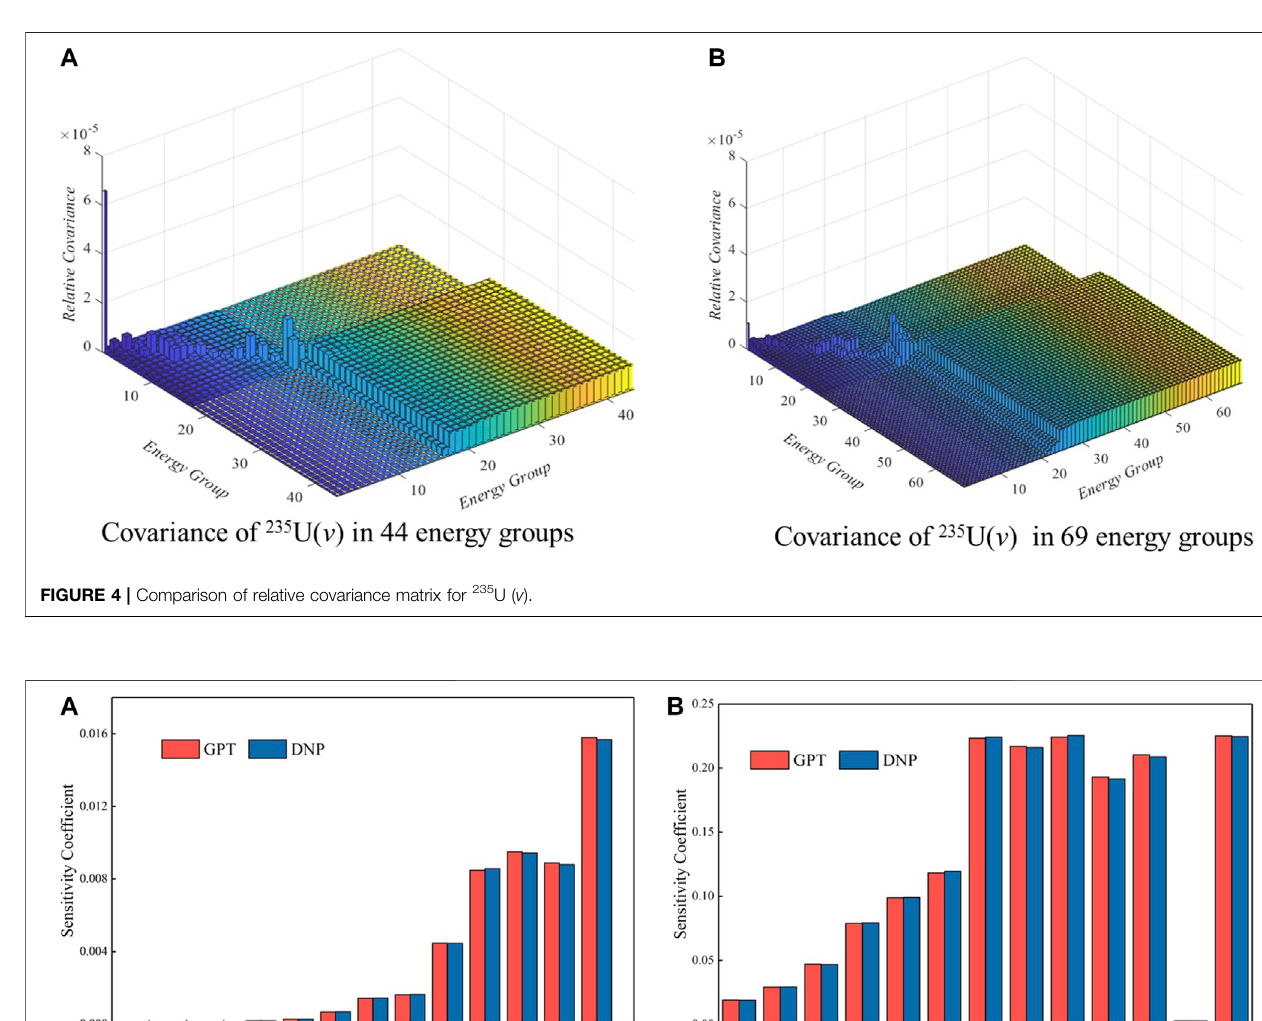
Frontiers in Energy Research |